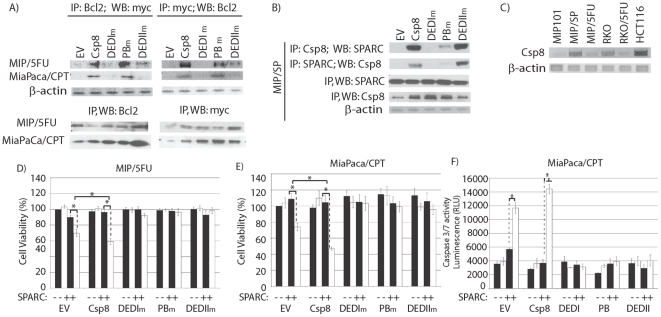
The DEDI-domain of caspase 8 is critical for its interaction with Bcl2.Vectors containing mutations in specific domains (DEDI, putative binding(PB), DEDII) of caspase 8 were transiently transfected into (A) MIP/5FU, MiaPaca/CPT or (B) MIP/SP cells, to determine the ability of the mutant proteins to co-IP with Bcl2 or SPARC. C) Basal levels of caspase 8 gene expression between various cancer cell lines. D–F) The effect of SPARC on cell viability (D, E) or apoptosis (F) in cells overexpressing mutant forms of caspase 8 was assessed. Cells were transiently transfected with wild-type caspase 8 (Csp8), mutants (DEDIm, PBm, and DEDIIm), or empty-vector (EV, control) for 48 h, followed by exposure to 100 ng/mL rSPARC for 48 h, and treated with 0 (▪) or 500 µM (□)5-FU for an additional 24 h. D–E) In resistant cells, exposure to rSPARC and 5-FU resulted in decreased cell viability following transfection with EV-control: MIP/5FU: 90.14±2.80 (SPARC) vs. 69.89±4.64% (SPARC+5-FU) (p<0.005); MiaPaca/CPT: 108.77±6.85 (SPARC) vs. 73.98±4.46% (SPARC+5-FU) (p<0.005). Over-expression of wild-type caspase 8 in resistant cells further decreased cell viability following exposure to rSPARC and 5-FU, in comparison to EV-controls: MIP/5FU: 69.89±4.64 (SPARC + 5-FU) vs. 59.21±3.66% (SPARC + 5-FU + caspase 8) (p = 0.03); MiaPaca/CPT: 73.98±4.46 (SPARC + 5-FU) vs. 46.78±2.01% (SPARC + 5-FU + caspase 8) (p<0.005). However, over-expression of mutant forms of caspase 8 abolished the reduction in cell viability seen in the presence of rSPARC. Results represent mean ± s.e. (n = 3 independent studies). *p<0.05, Student's t-test.